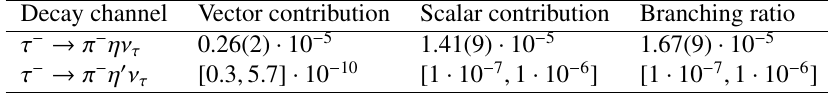
Table 1. Branching ratio predictions for τ → π η ( ) ν τ [3]. Three coupled channels for the scalar contribution.